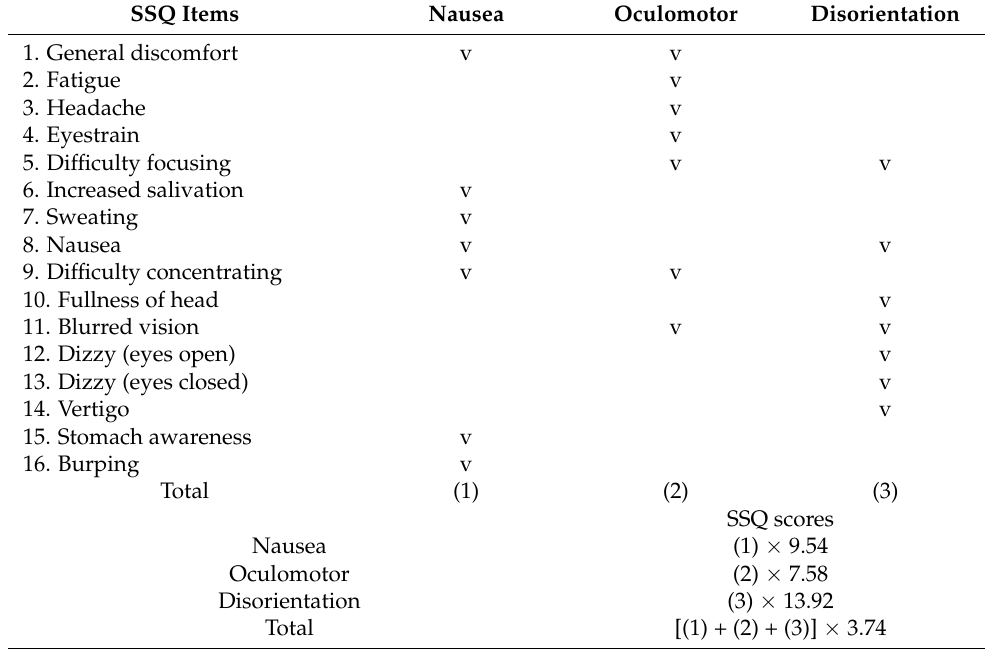
Table 1. Computation of nausea, oculomotor, disorientation, and total severity